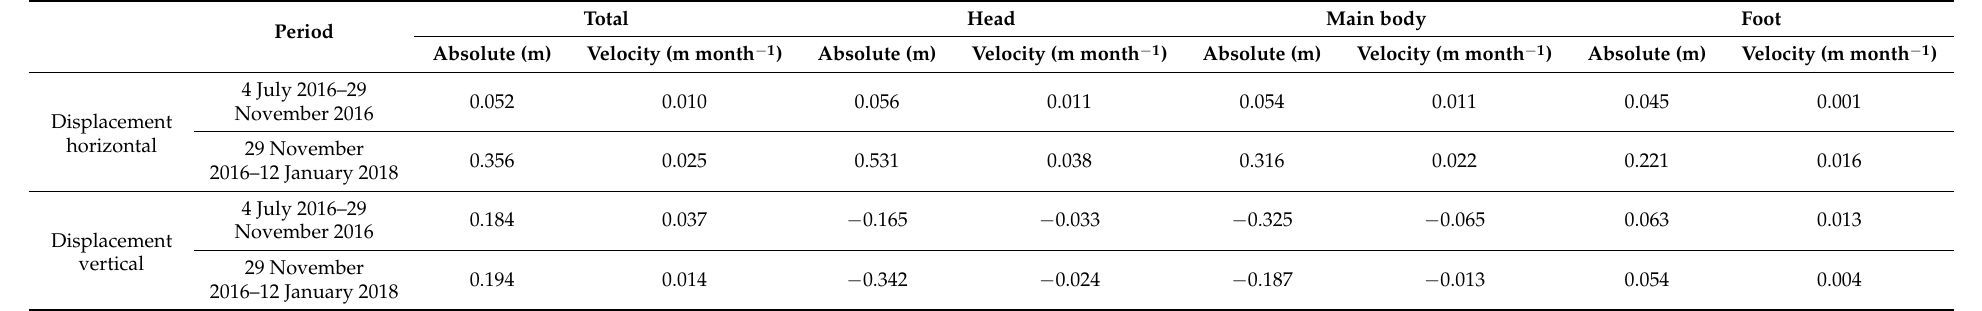
Table 9. Horizontal and vertical displacements and velocities calculated at monitoring points in the landslide area of the Colinas Lojanas study area. Displacements are expressed as m and velocities as m month − 1